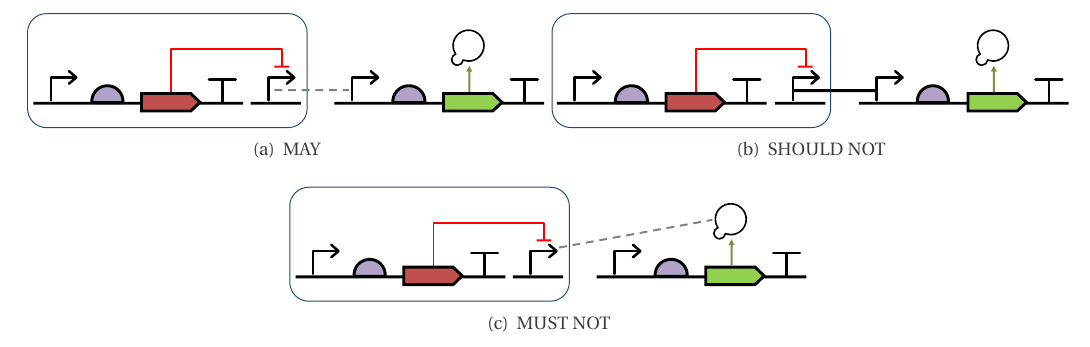
Figure 20: Examples of recommended and problematic mappings: (a) mapping showing that the promoter inside the module on the left is also used in the construct on the right, (b) mapping is not visually distinct from nucleic acid backbone, (c) mapping cannot identify a promoter with a macromolecule